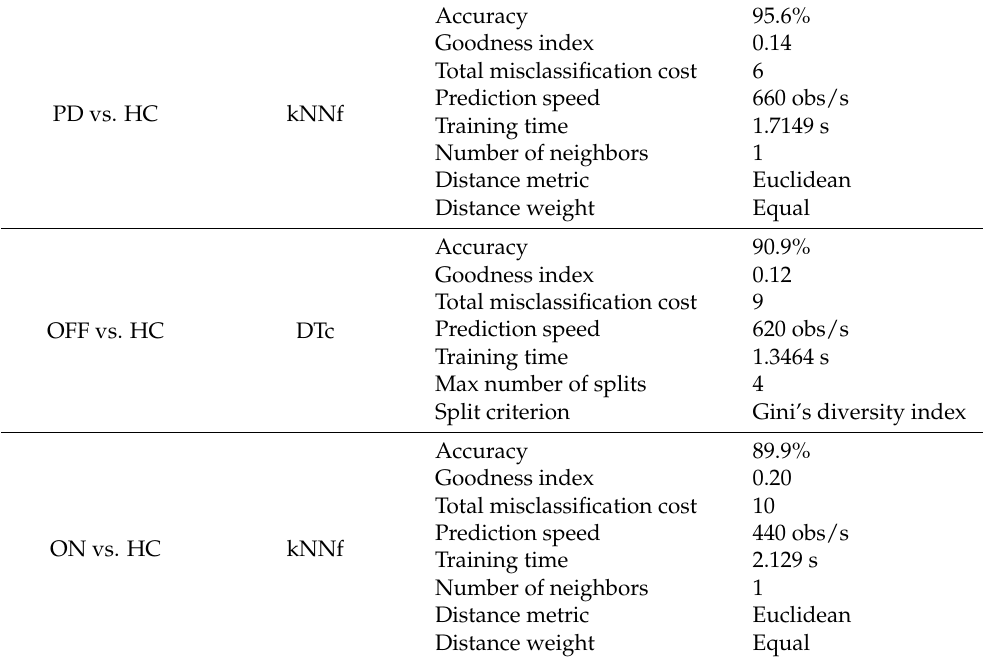
Table 4. Best-performing machine learning classifier’s characteristics and parameters. Accuracy 95.6% Goodness index 0.14 Total misclassification PD vs. HC kNNf